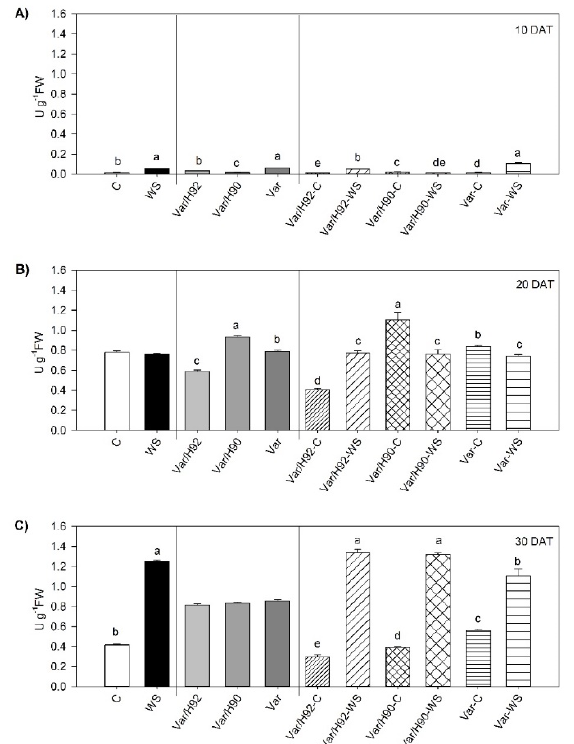
Figure 4. Catalase activity (as H 2 O 2 reduction, U g − 1 FW) in the leaves of the ungrafted plants (Var, variety “Sueca”) and Var grafted onto H92 or H90 (Var/H92 and Var/H90) under the water stress (WS) or control conditions (C) at 10 ( A ), 20 ( B ), and 30 ( C ) days after treatment (DAT). Different letters indicate significant differences at p < 0.05 (LSD test) for each measurement time separately. No letters in ( B ) an ( C ) indicate no significant differences. Data are the mean of four replicates and the error bars belong to the standard deviation for each plant type and treatment combination.